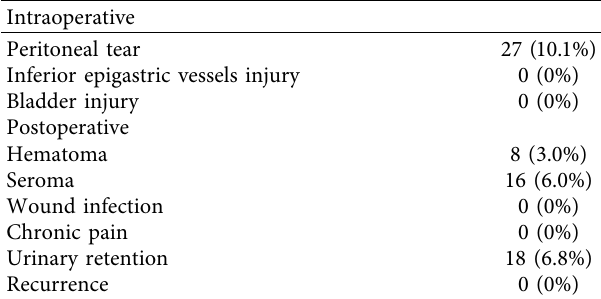
Figure 2: Totally extraperitoneal herniorrhaphy (TEP). (a) Dissecting the retromuscular space caudally. (b) Percutaneous needle con- firmation for measuring the length of the arcuate line. Classical AL: single sharp well-defined arcuate line (4.5cm below the umbilicus) (black arrow). (c) Low AL: multiple and low AL in the incomplete PRS (11cm below the umbilicus) (black arrow). (d) Absent AL in the complete PRS. (e) Artificial AL was surgically created by incising PRS and the transversalis fascia beneath. (f) Retromuscular space (ventrally) and preperitoneal space (dorsally) were seen clearly. (g) The vas deferens was freed to obliterated umbilical artery. (h) Weakness of MPO was covered by a large mesh. RAM � rectus abdominis muscle, PRS � posterior rectus sheath, IEV � inferior epigastric vessels, R � right, M � middle. AL � arcuate line, SP � symphysis pubis, CL � Cooper’s ligament, VD � vas deferens, OUA � obliterated umbilical artery, and HS � hernia sac. Table 2: Intraoperative and postoperative